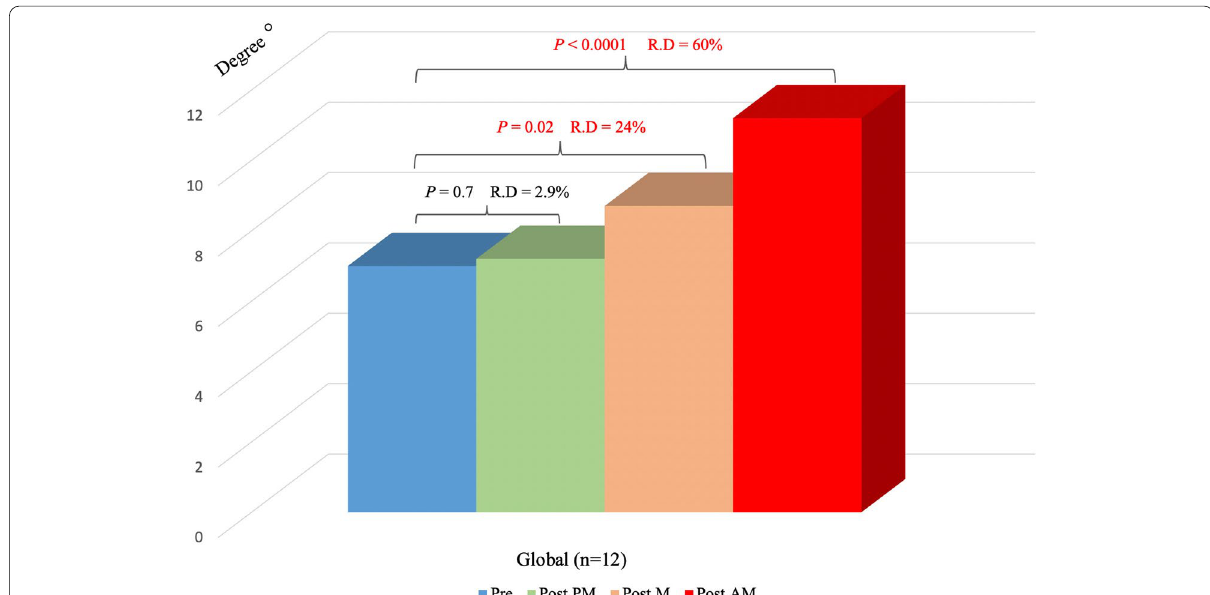
12). The red text indicates significant changes. R. D, relative difference; AM, =